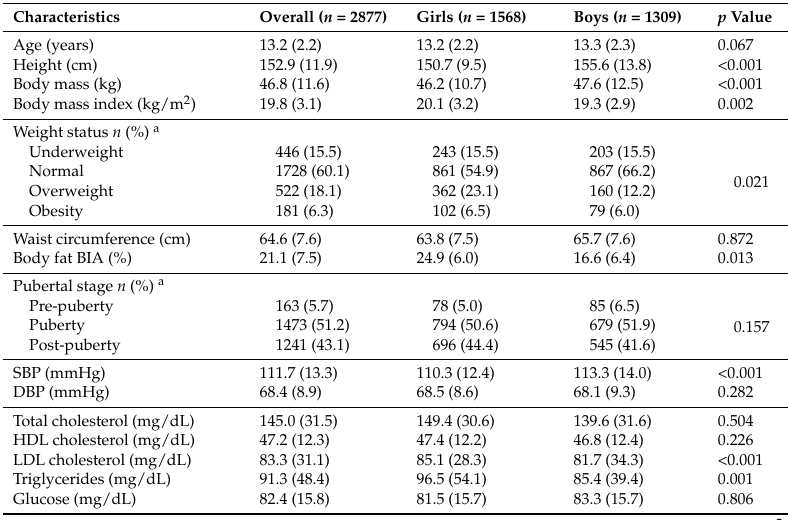
Table 1. Characteristics among a sample of children and adolescents from Bogota, Colombia (mean (SD) or